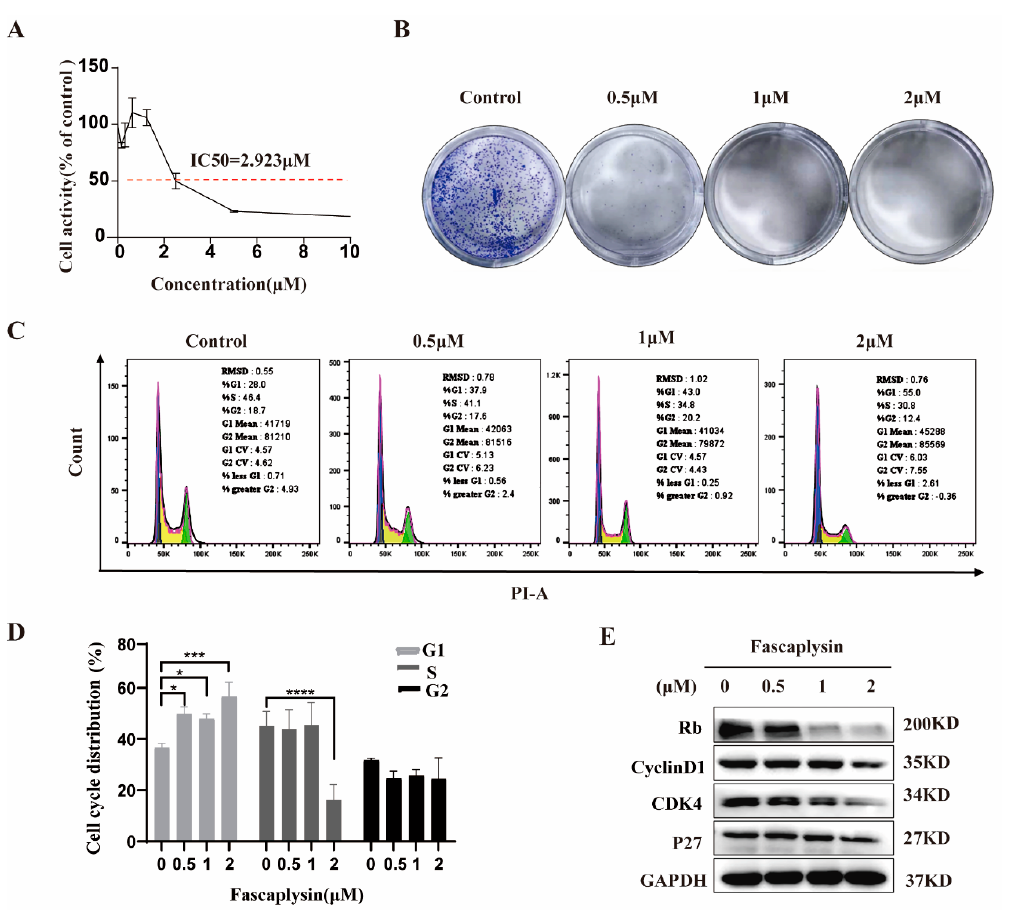
Figure 1. Fascaplysin arrested the cell cycle of A549 cells by regulating cycle-related proteins. ( A ) Cell viability was measured by CCK-8 assay after treatment of A549 cells with different doses of fascaplysin for 24 h. ( B ) Representative images of A549 cell colony formation after treatment with fascaplysin. ( C , D ) Representative results of cell cycle and quantitative analysis. Data are presented as mean ± SD of three independent experiments compared with control. * p < 0.05, *** p < 0.001, and **** p < 0.0001. ( E ) We examined the expression of cell cycle-related proteins by Western blotting after treating A549 cells with fascaplysin (0, 0.5, 1, and 2 μ M) for 3 h.